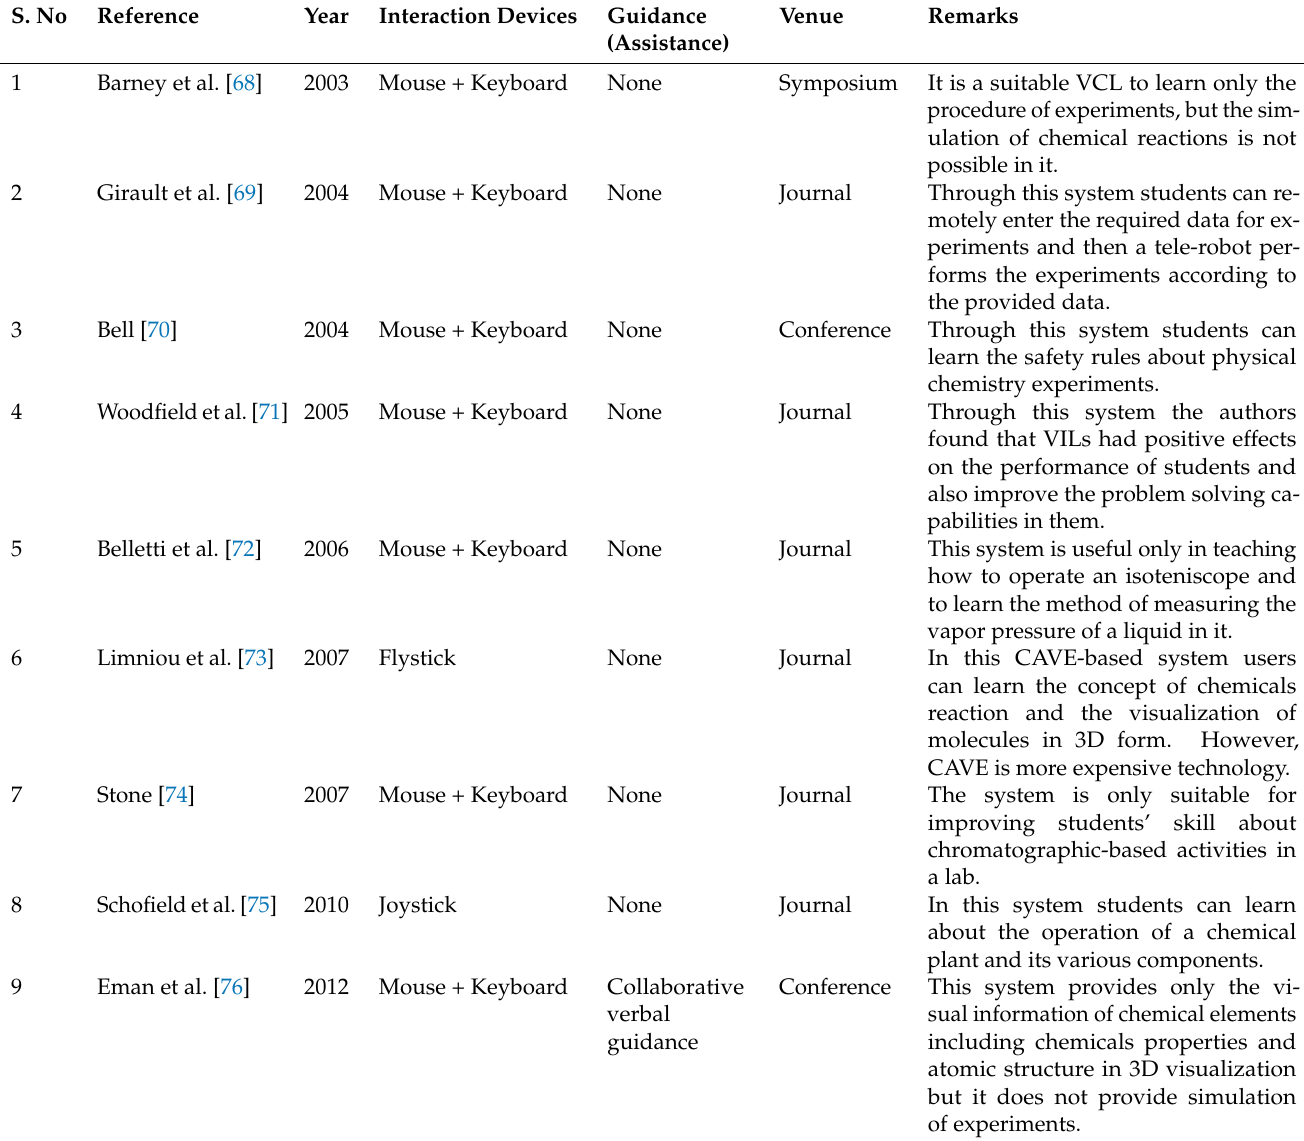
Table 2. Analysis of the existing interactive chemistry laboratories in